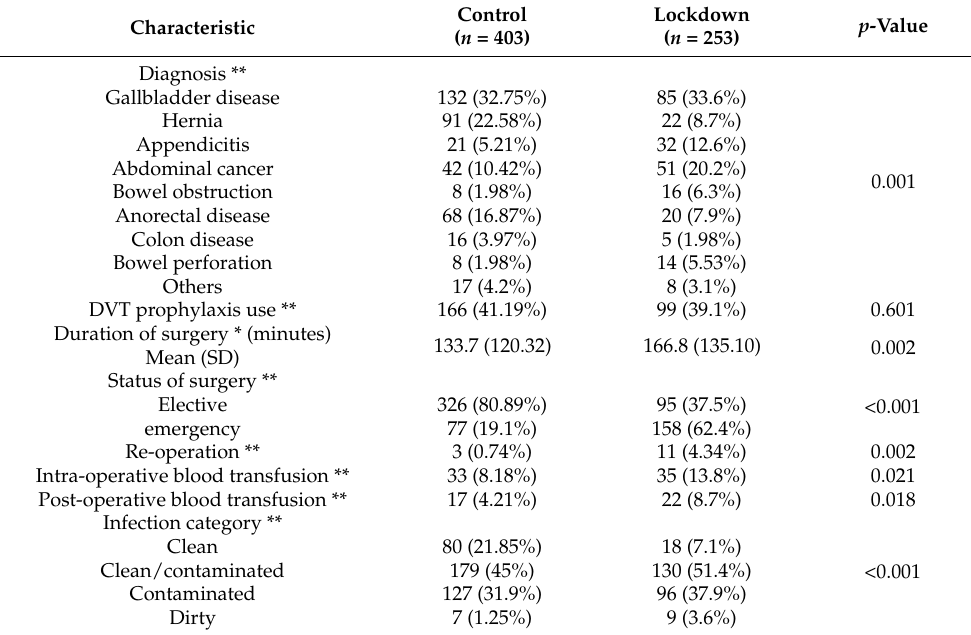
Figure 1. Types of surgeries performed during control and lockdown periods. Table 2. Assessment of the peri-operative variables and surgical activities of the control and lockdown